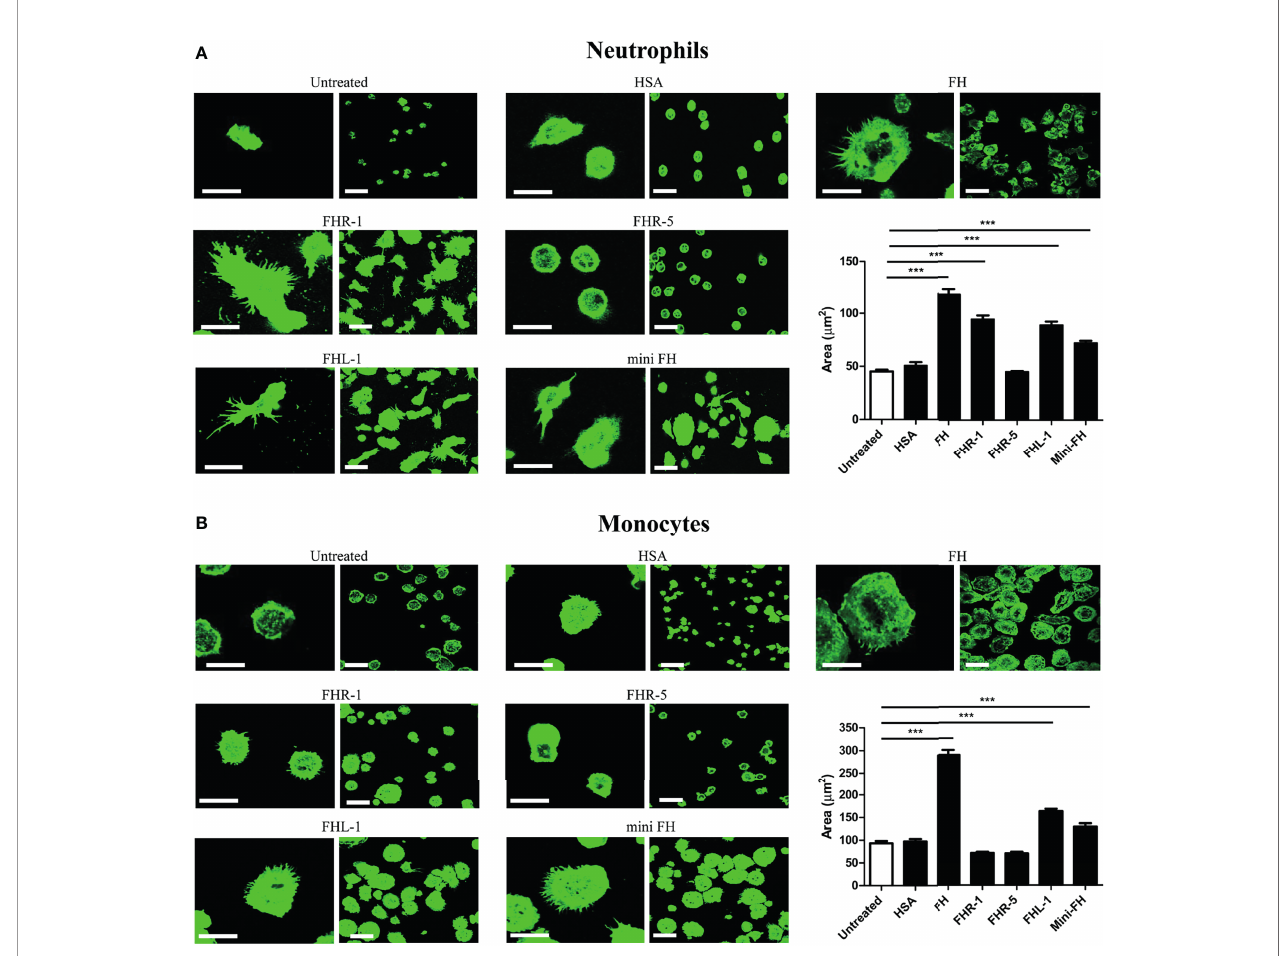
FIGURE 5 | FH family proteins in fl uence spreading of neutrophil granulocytes and monocytes. Confocal laser scanning images of (A) neutrophils and (B) monocytes in response to 300 nM of immobilized proteins on chambered microplate wells. The contact surface of the cells was monitored by labelling F-actin with phalloidin- A488. Original scale bars, 20 µm (left columns) and 40 µm (right columns). Confocal images shown are representative of four (neutrophils) or fi ve (monocytes) independent experiments. The contact zone areas of phalloidin-A488 labelled neutrophils and monocytes were quanti fi ed using ImageJ software from 150 cells in each experiment. Error bars represent means + SEM. Differences with p < 0.05 were considered statistically signi fi cant and compared to untreated samples (non- coated microplate surface) (one-way ANOVA with Bonferroni ’ s multiple comparison test, *** p <